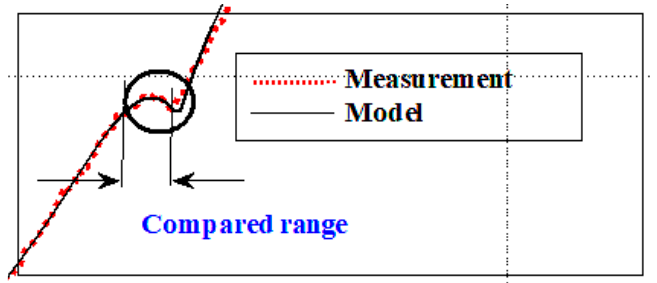
Figure 7. The transient section of the model and measurement for which the correlation was calculated (fragment of the graph of Figure 6).